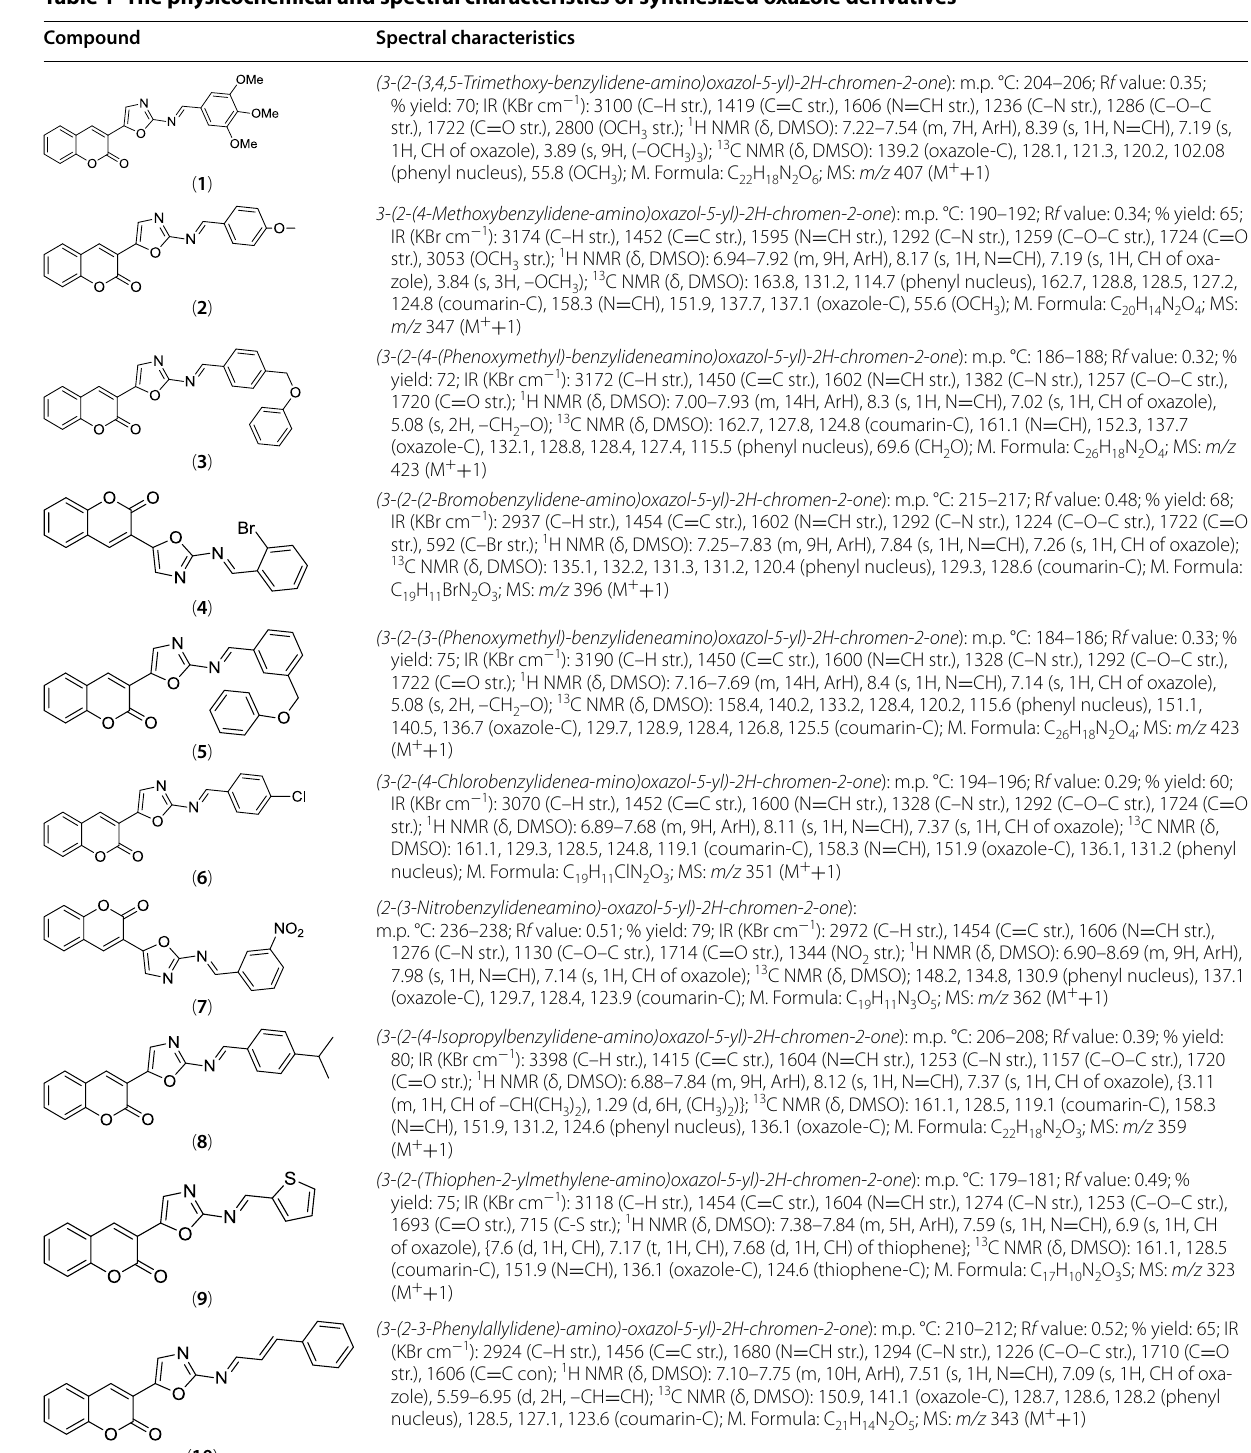
Table 1 The physicochemical and spectral characteristics of synthesized oxazole derivatives